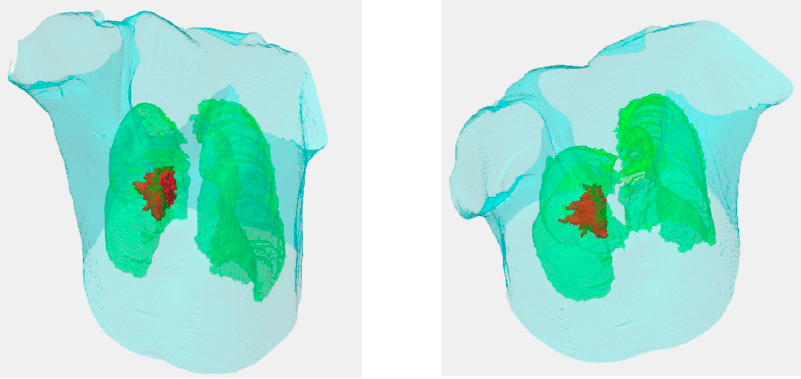
Figure 5. The 3D visualizations of the body shape, lungs, and GTV. The cyan denotes the body shape, green denotes the lungs, and the red denotes the GTV.